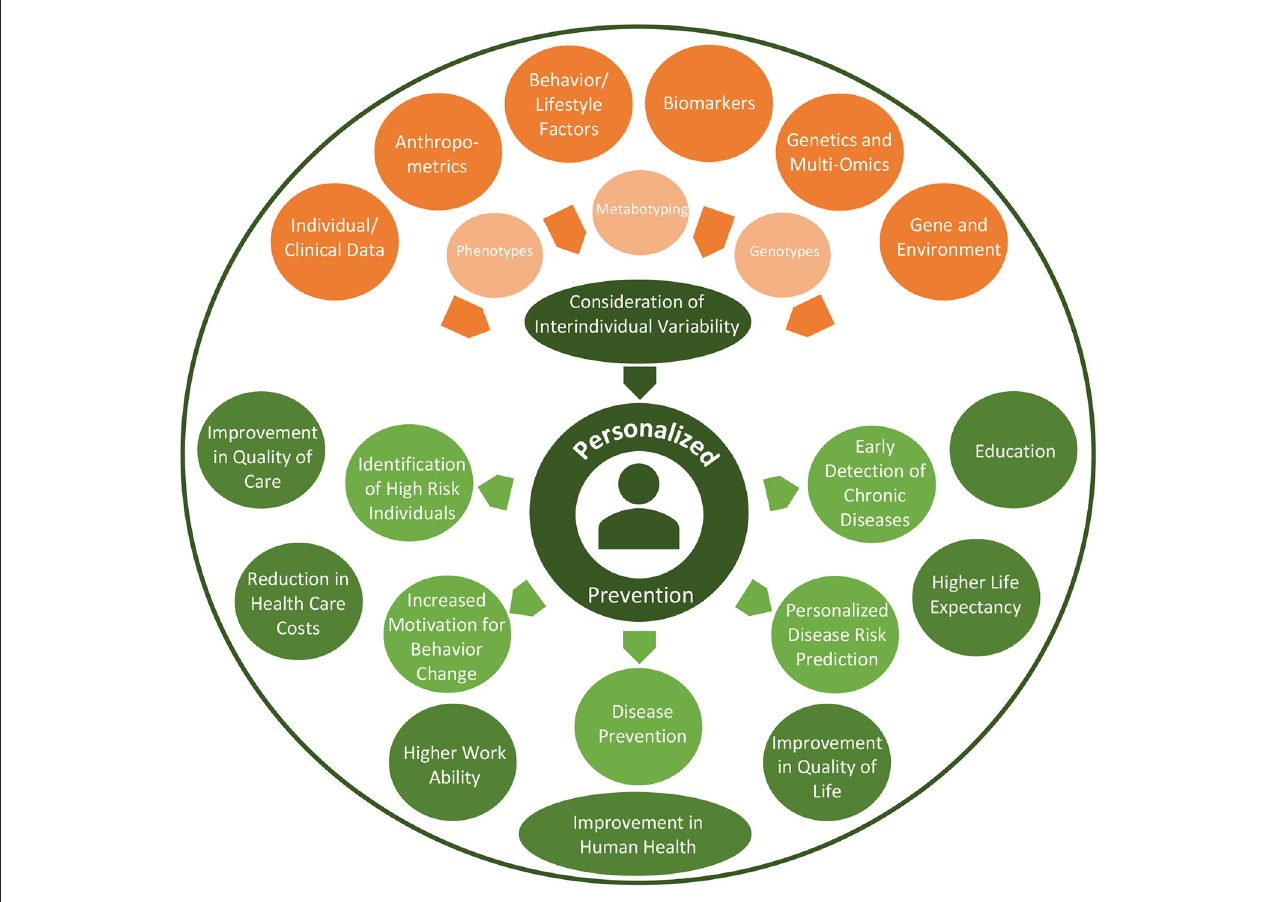
FIGURE2 Prospects of personalized